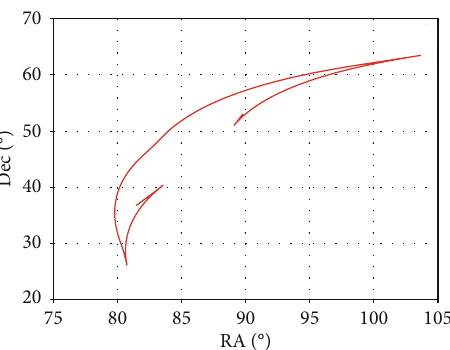
Figure 17: Auxiliary LoS vector.